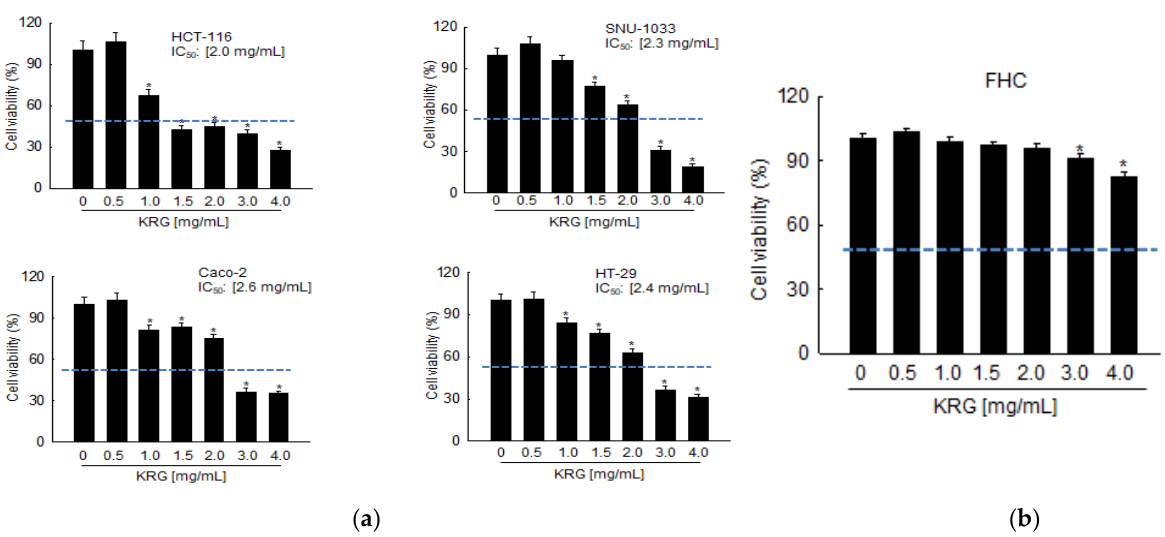
Figure 1. KRG extract induces cell death in colon cancer cells. Cell viability following KRG extract treatment for 48 h was assessed using the MTT assay ( a ) in HCT-116, SNU-1033, Caco-2, HT-29, and ( b ) FHC cells. The IC 50 value of each cancer cell line is presented. The blue dot line indicates 50% of cell viability. * p < 0.05 vs. untreated control.